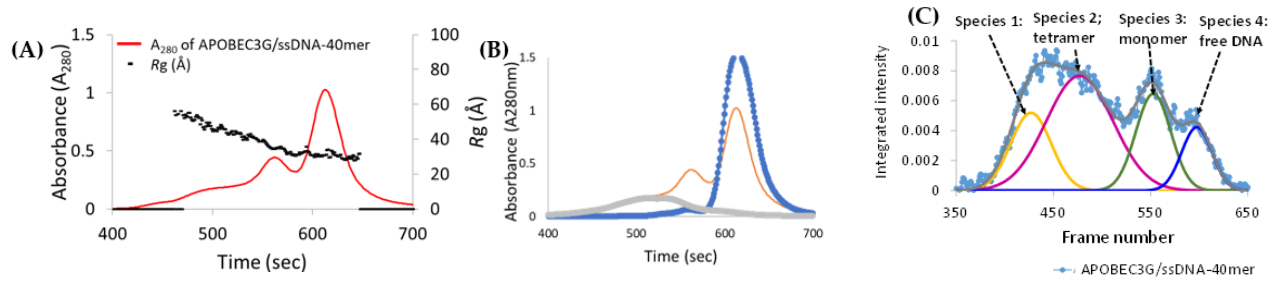
Figure 4. SEC-FLPC profile comparison of apo A3G fl and A3G fl / CCdZ-T 30 -oligo shows complex formation. ( A ) SEC-FPLC elution profile of A3G fl with CCdZ-T 30 -oligo (red, abbreviated as ssDNA- 40mer in the figure) at a 1 to 2 molar ratio, with R g trace values (black dots) superimposed. Only the data between the thickened black lines on the x -axis were retained for analysis. ( B ) Superposition of SEC-FPLC elution profiles of A3G fl alone (gray), of CCdZ-T 30 -oligo (blue) and of A3G fl with CCdZ-T 30 -oligo (abbreviated as ssDNA-40mer in the figure) at a 1 to 2 ratio (orange). ( C ) Gaussian decomposition analysis using US-SOMO. Experiment conducted using 2.5 mg/mL A3G fl in a 1 to 2 molar ratio with CCdZ-T 30 -oligo in A3G fl -SAXS buffer at 25 °C (50 mM phosphate, pH 6.0, 200 mM NaCl, 2 mM β -ME, 5% glycerol, 200 µM Na 2 -EDTA). In the text, the descriptor C for complex is added to distinguish these species from those identified in SAXS data of A3G fl alone .